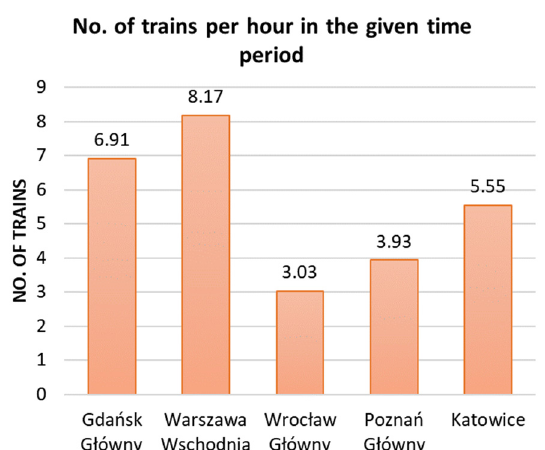
Figure 3. Number of trains served by the station in a given time period. Source: own study.